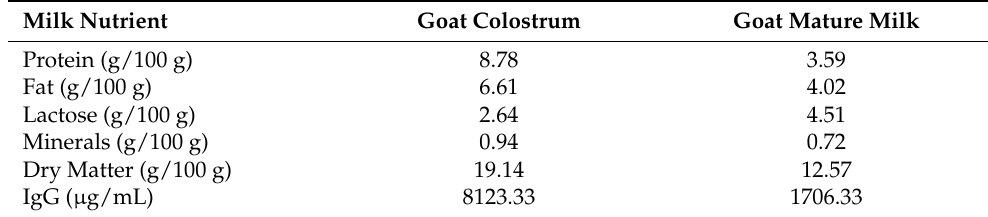
Table 5. Chemical composition of GC and goat mature